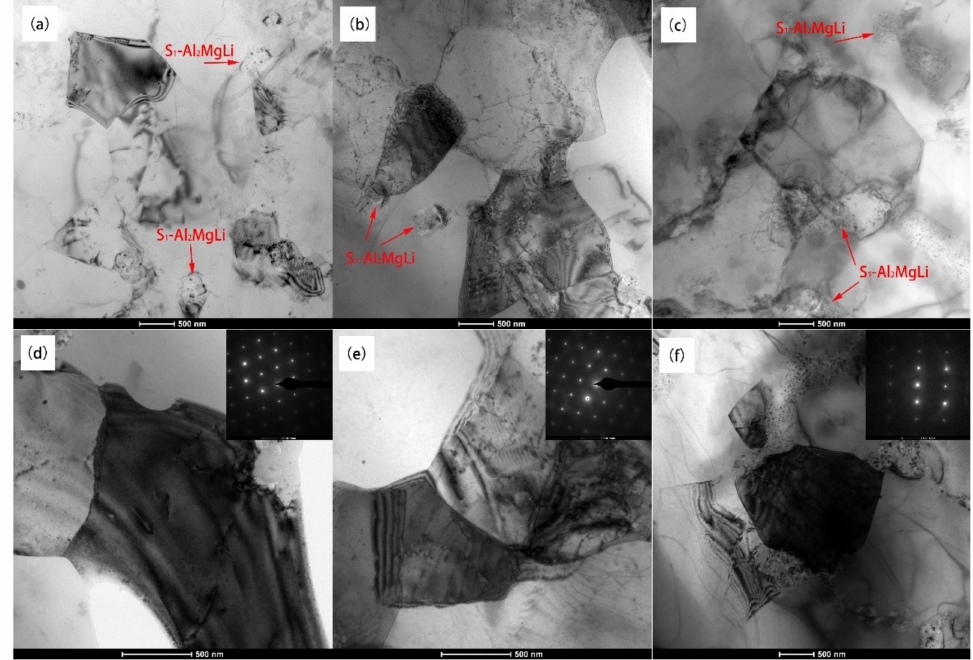
Figure 7. TEM images of ECAP 16-pass Al-5.5Mg-xLi-0.1Zr (wt%) alloy with di ff erent Li contents: ( a , d ) 1.6 wt%, ( b , e ) 2.0 wt%, ( c , f ) 2.5